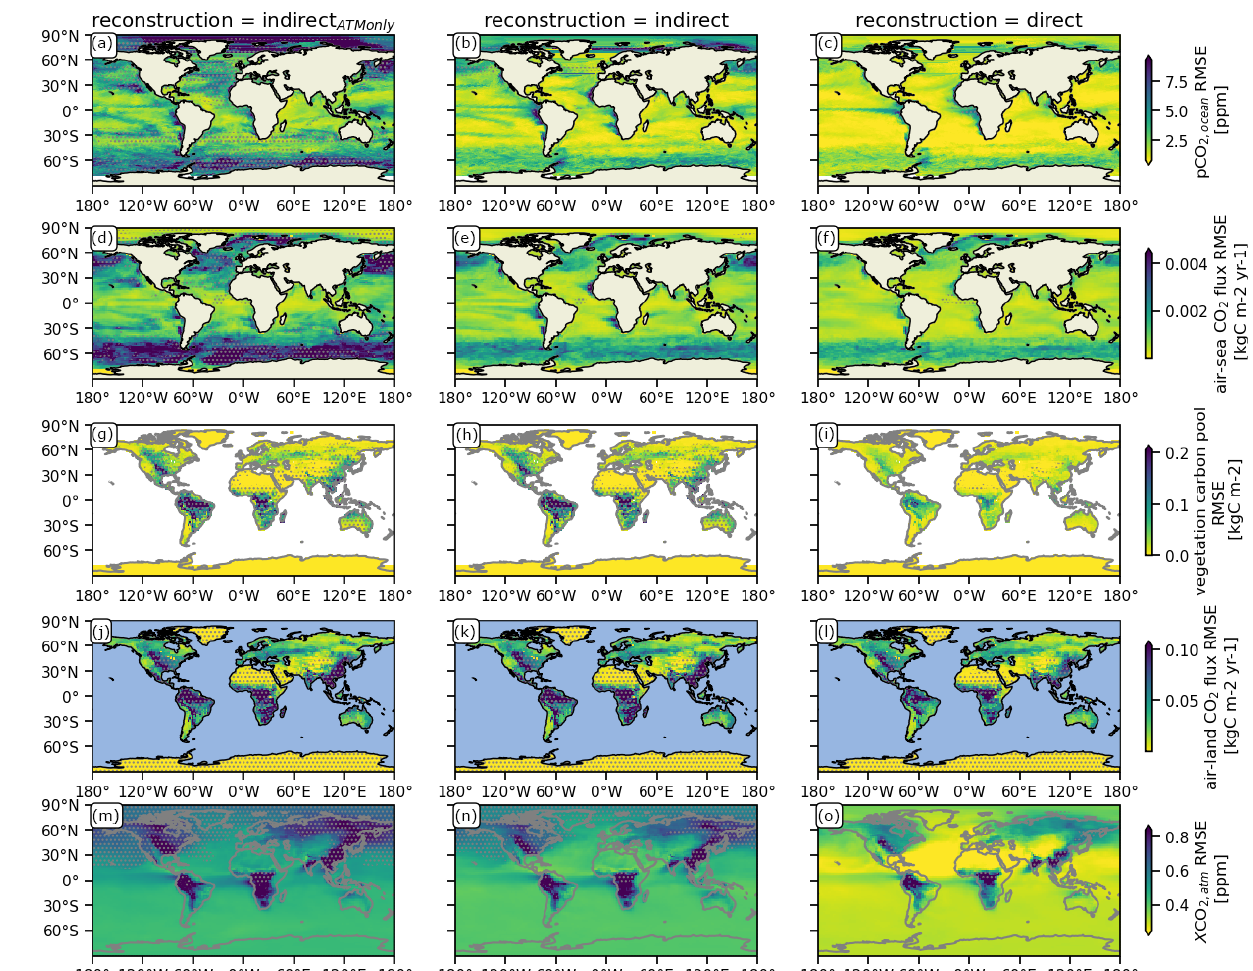
Figure B3. The same as Fig. B2 but for RMSE after bias